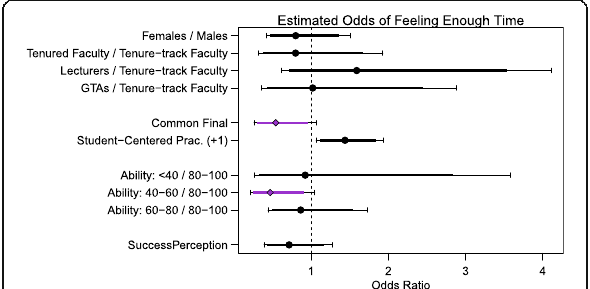
Fig. 2 Instructor results. Estimated effects of the instructor factors on the odds that an instructor reported there was enough time in class to understand difficult ideas. The points represent the best estimate of the odds ratio, and the intervals represent the 90% (smaller, potentially colored) and 95% (wider, black ) confidence intervals for the ratios. Confidence intervals that do not overlap one (shown in purple with diamond points ) indicate the factor has a statistically significant association with instructor OTL reports at the .10 significance